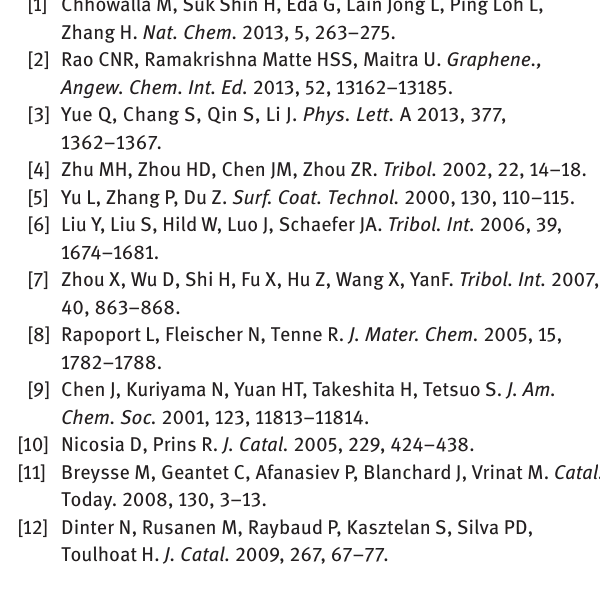
Figure 11: XRD patterns after TPR of nanospheres (A) NiMoS CoMoS 2